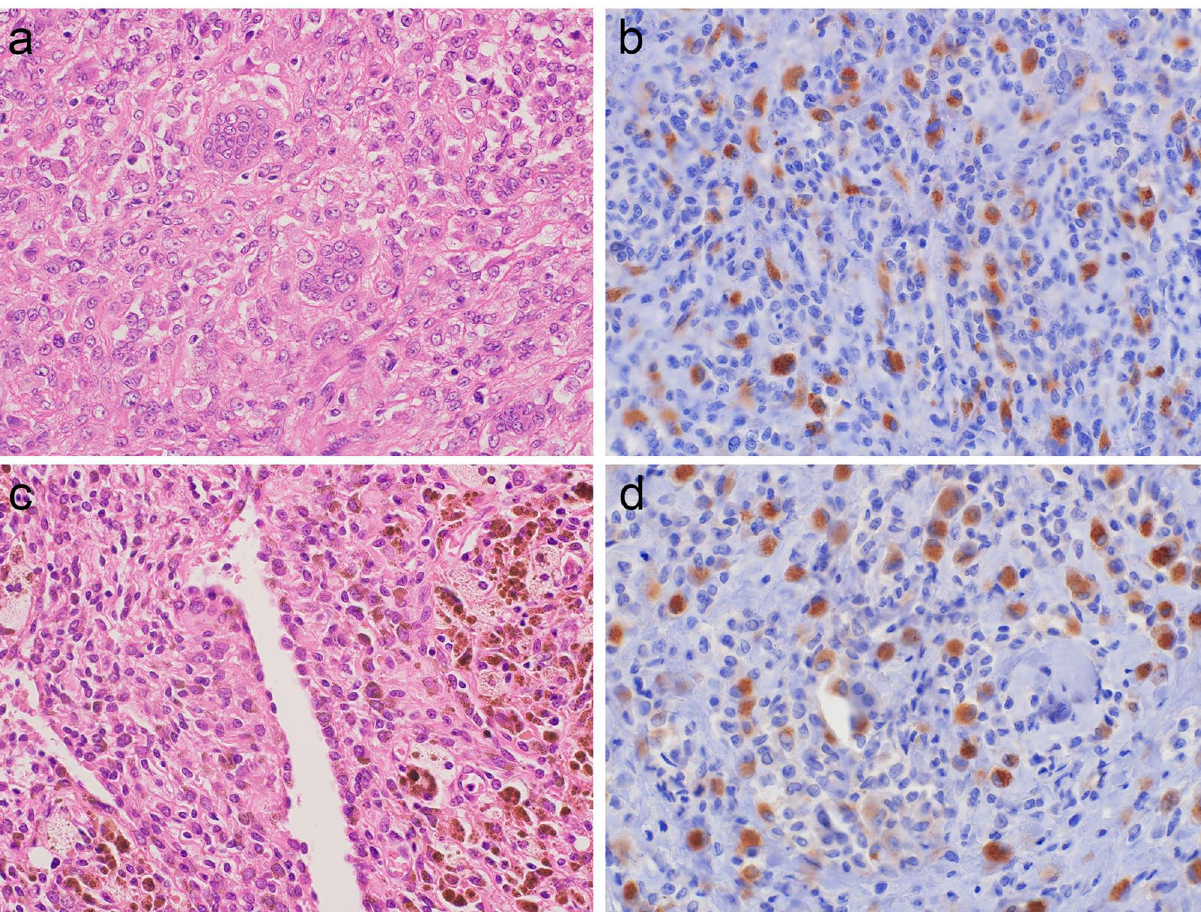
Fig. 1 Histology and CSF1 IHC of TSGCTs. a. LTSGCT showed a well-circumscribed mass that consisted of admixture of mononuclear cells, osteoclast-like giant cells, and inflammatory infiltrates with various degrees of collagenous stroma b. CSF1-positive mononuclear tumor cells were scattered in the tumor c. DTSGCT was composed of various cells similar to LTSGCT that exhibited sheet proliferation with often cleft-like structures and marked hemosiderin deposits d. CSF1-positive mononuclear tumor cells were scattered in the